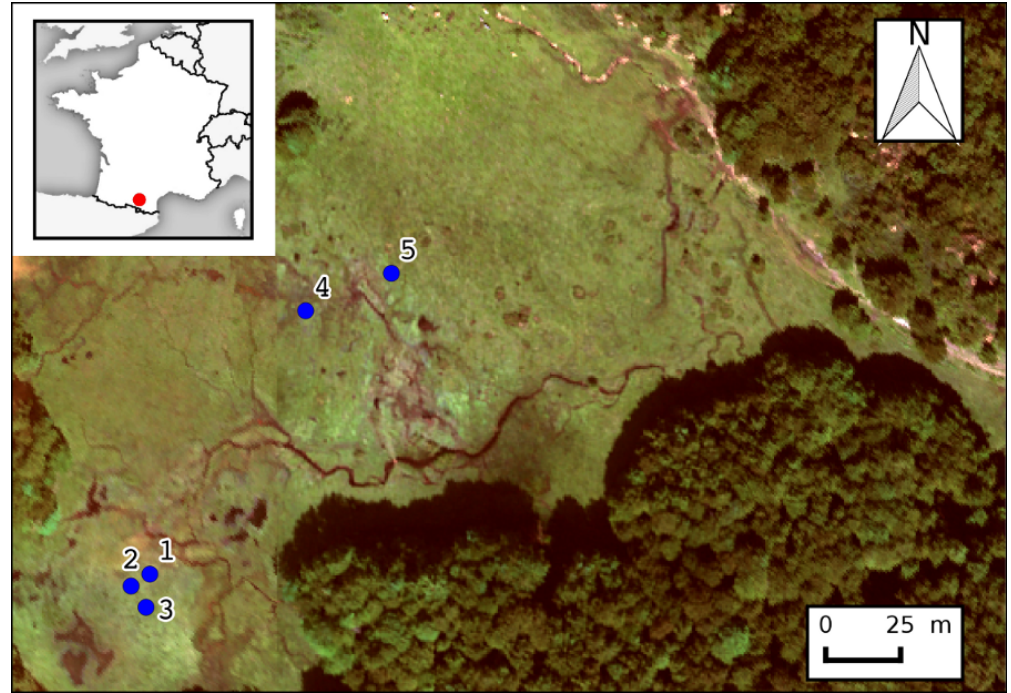
Figure A1. Location of the in situ spectroradiometer measurements for the plots of Sphagnum sp. (SPHA).